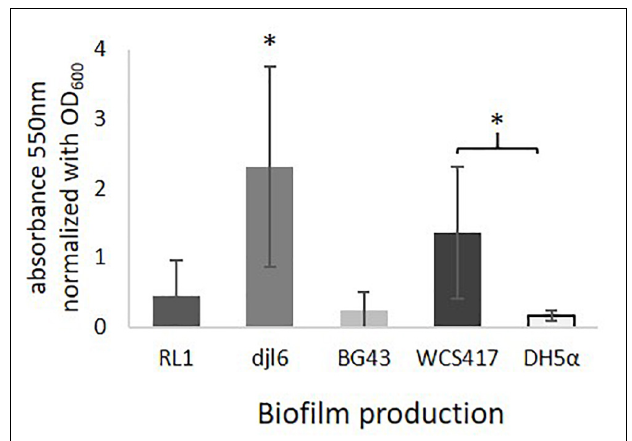
FIGURE 6 | Ability to produce Biofilms with averaged results from 3 experiments normalized to OD600 = 1. Significant difference is indicated by asterisks representing ∗ P <